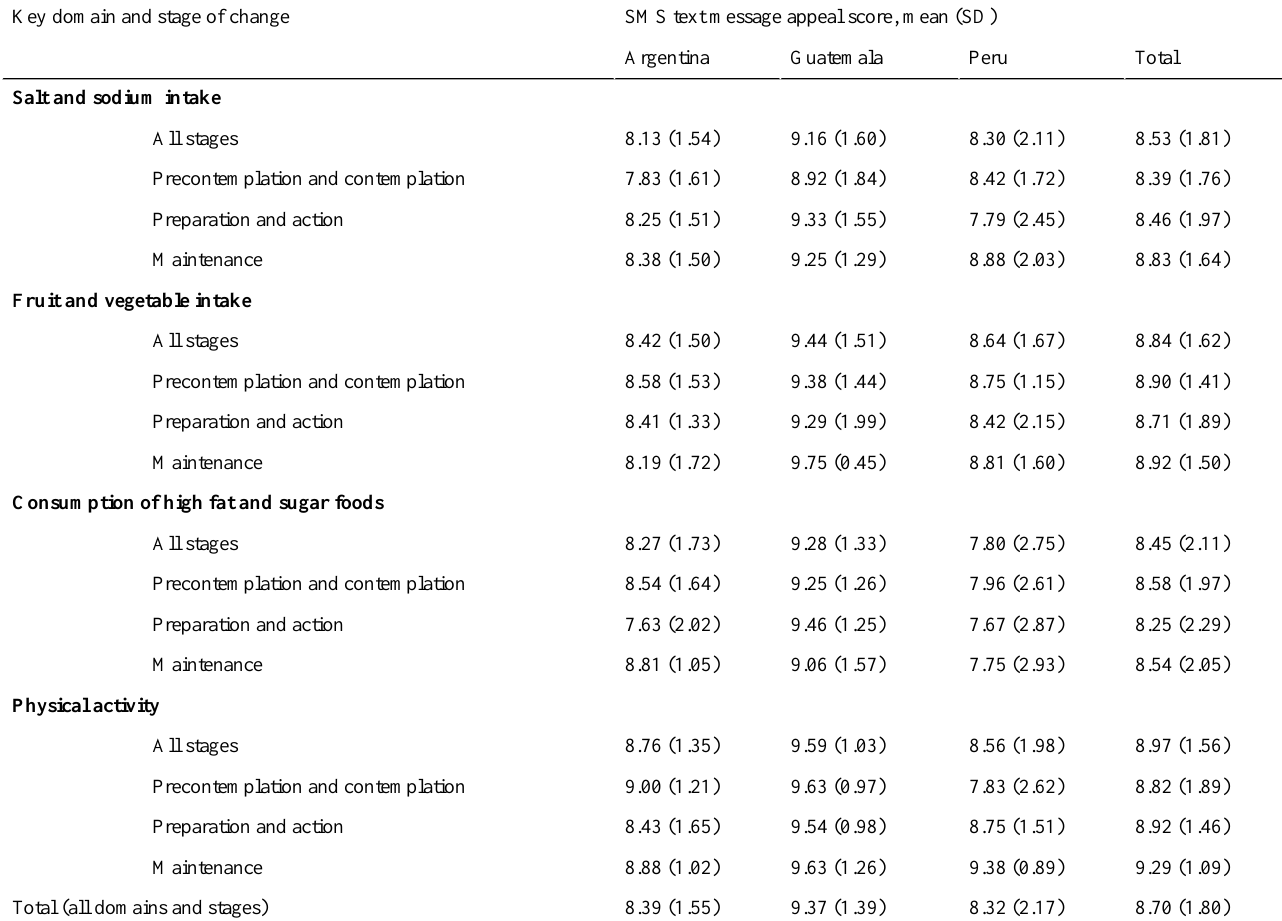
Table 4. SMS average appeal scores by country, key domain, and stage of change.